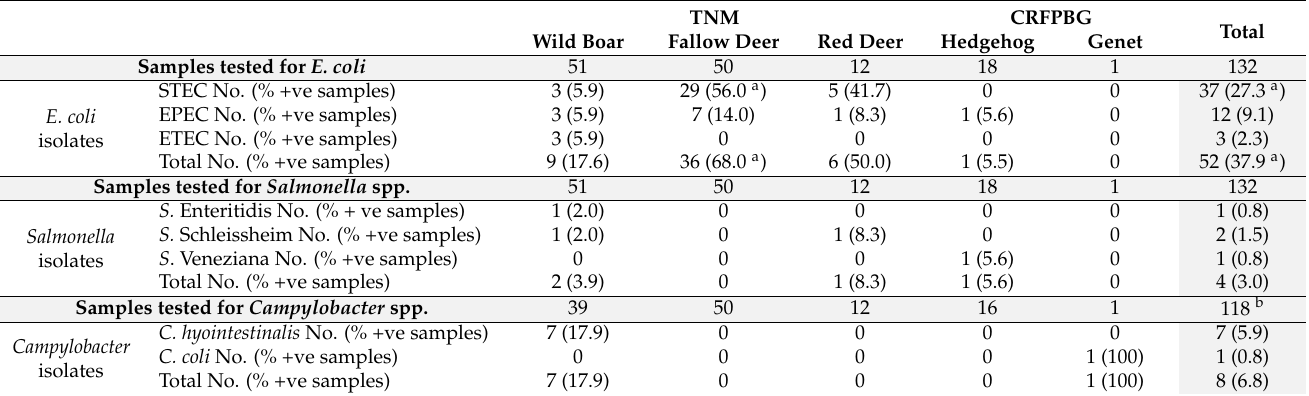
Table 1. Isolation and characterization of STEC and non-STEC E. coli , Salmonella spp. and Campylobac- ter spp. in 132 tested samples. TNM